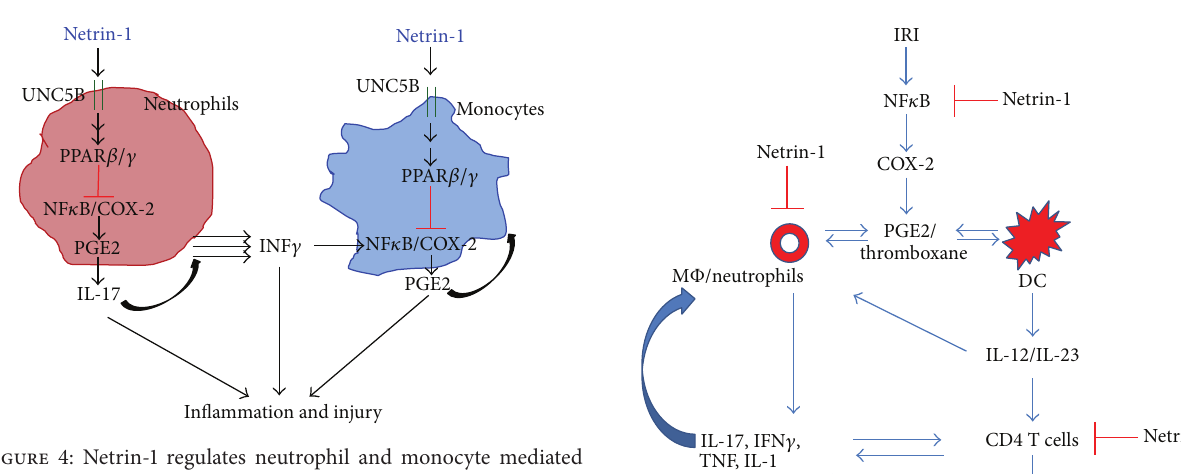
Figure 4: Netrin-1 regulates neutrophil and monocyte mediated inflammation through suppression of COX-2 expression and PGE2 production. Netrin-1 acting through UNC5B receptor induces the activation of PPAR 𝛾 . Activation of PPAR 𝛾 and other signaling pathways like PI3K causes suppression of I 𝜅 B degradation and inac- tivation of NF 𝜅 B transcription factor. NF 𝜅 B activation is required for COX-2 induction. In the absence of NF 𝜅 B activation COX-2 expression and PGE2 production was suppressed. This leads to reduced IL-17 production and IFN 𝛾 production thereby suppresses inflammation and tissue injury during ischemia reperfusion injury.